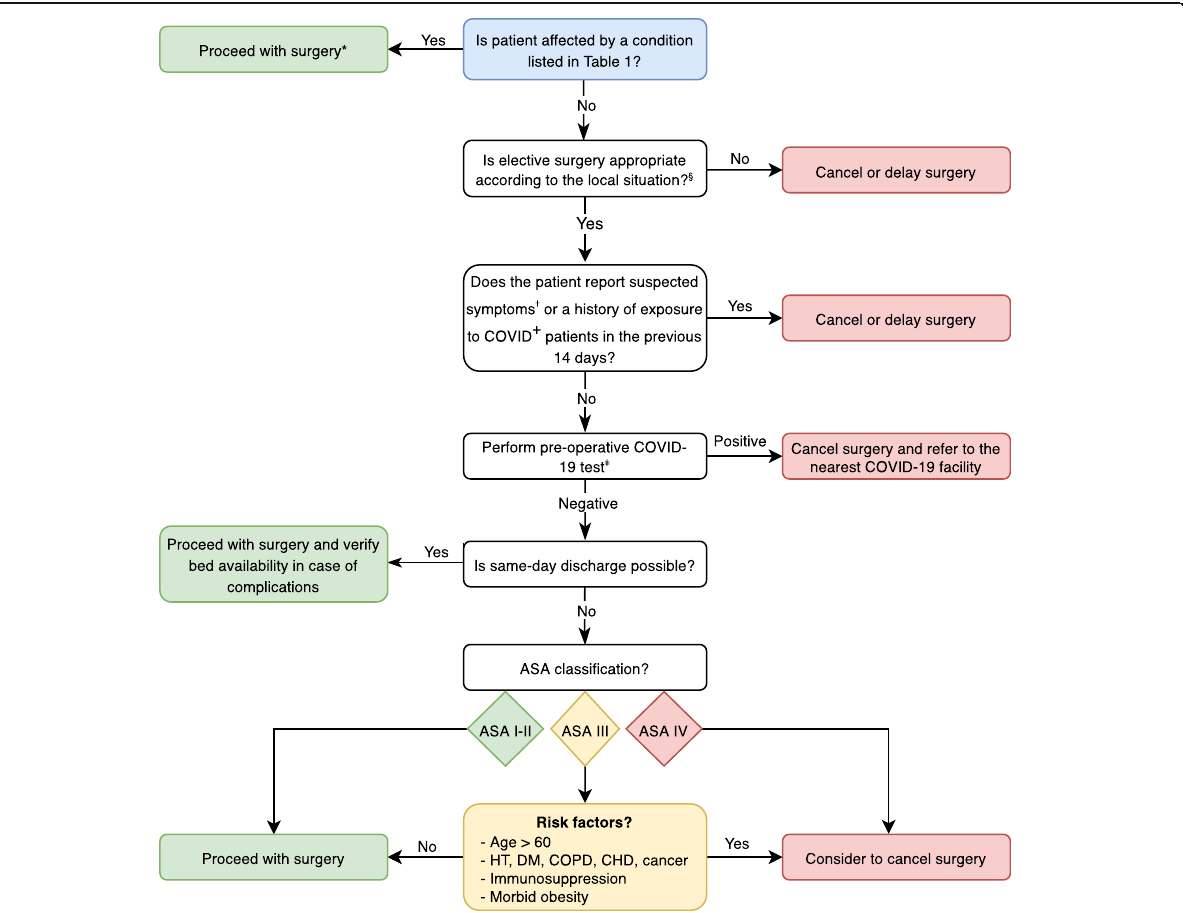
Fig. 1 Decisional algorithm for guiding surgical indication during the COVID-19 pandemic. *A preoperative nasopharyngeal swab should be obtained and tested for SARS-CoV-2 as soon as reasonably possible without delaying surgery. § Elective surgery indication should be judiciously pondered depending on availability of ICU beds, ventilators, PPE, workforce, blood units as well as institutional priorities. † Suspected symptoms include fever and at least one sign/symptom of respiratory disease, e.g. , cough, shortness of breath [54]. ǂ In case of a pending or undetermined result, consider whether to postpone surgery or to proceed adopting all the precautions for suspected or COVID + patients. ASA: American Society of Anesthesiologists; HT: hypertension; DM: diabetes mellitus; COPD: chronic obstructive pulmonary disease; CHD: cardiac ischemic